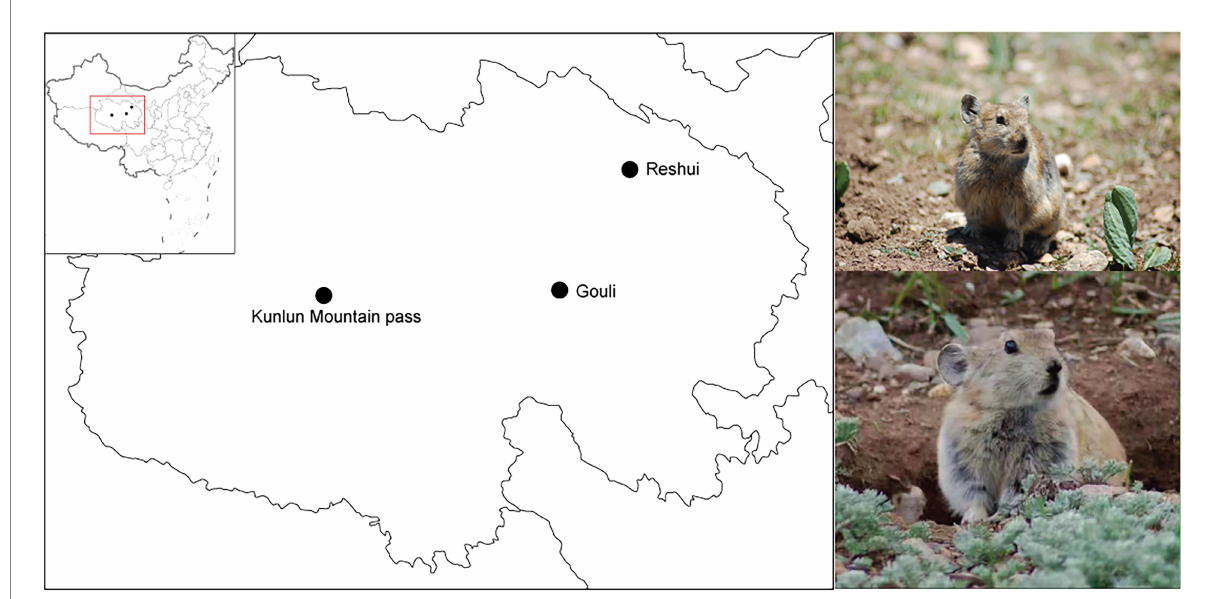
FIGURE 1 Sampling sites along the Qinghai–Tibet Highway. The three black dots represent the sampling site locations at the Kunlun Mountain Pass, Gouli Clinic, and Reshui Village. The photos to the right display the most obvious features of the Plateau